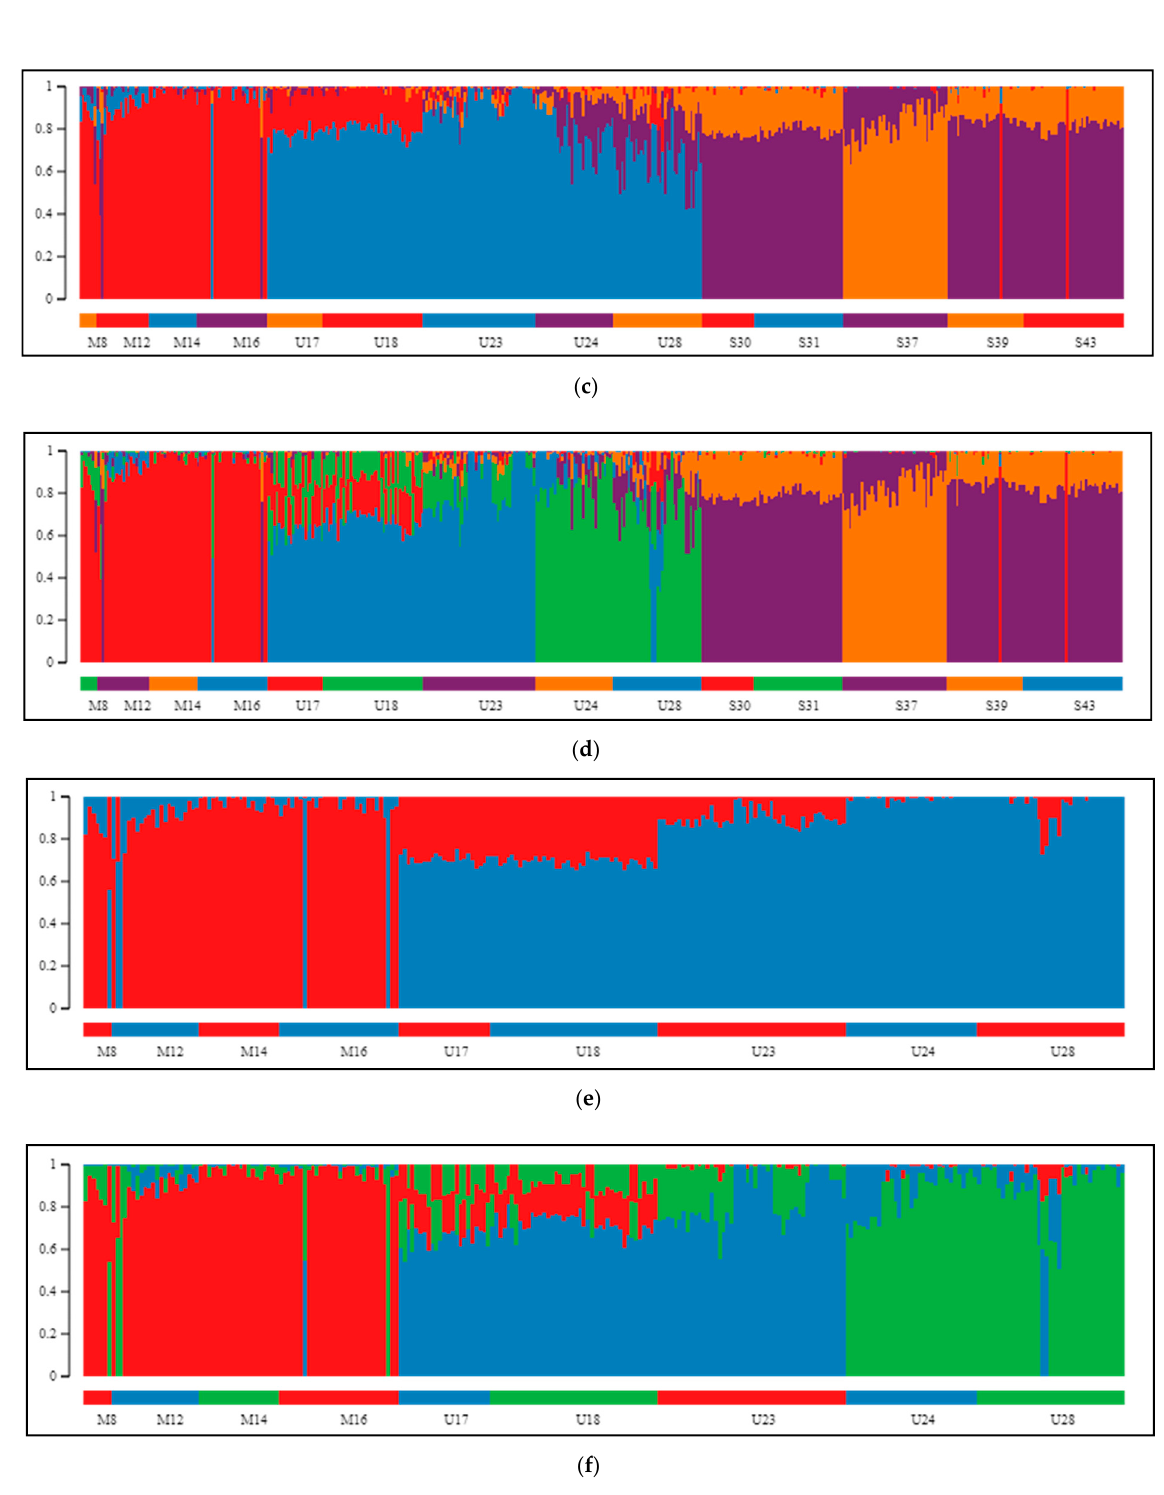
Figure 3. Clustering of 14 inspected pine populations, as proposed by the STRUCTURE algorithm. Separation of populations of three species into ( a ) two, ( b ) three, ( c ) four, or ( d ) five distinct groups. K = 2 and K = 5 were pointed out as the best supported clustering, depending on whether the result for K = 1 was under consideration. ( e ) After exclusion of Scots pine samples, K = 2 was indicated as the most likely assemble, closely corresponding with the two mountain taxa. ( f ) The second best supported structure of the tested P. mugo complex populations consisted of three groups ( K = 3): dwarf pine specimens, Pyrenean pine representatives from Pyrenees and its accessions from isolated populations in Sierra de Gudar and Massif Central together. Scale on the left and vertical bars represent the proportion of each genome being composed of variants specific to particular clusters. Horizontal color bars at the bottom of each chart label distinct populations.